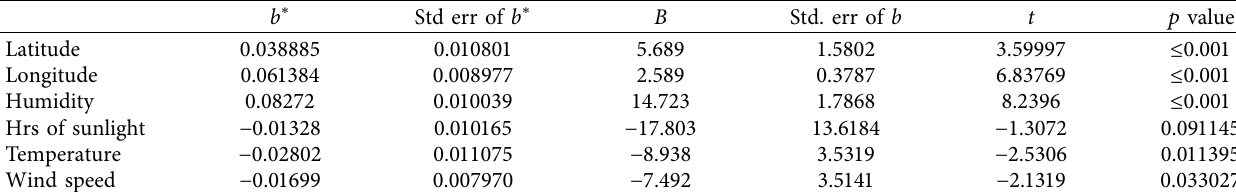
Table 3: Regression summary for dependent variables: confirmed